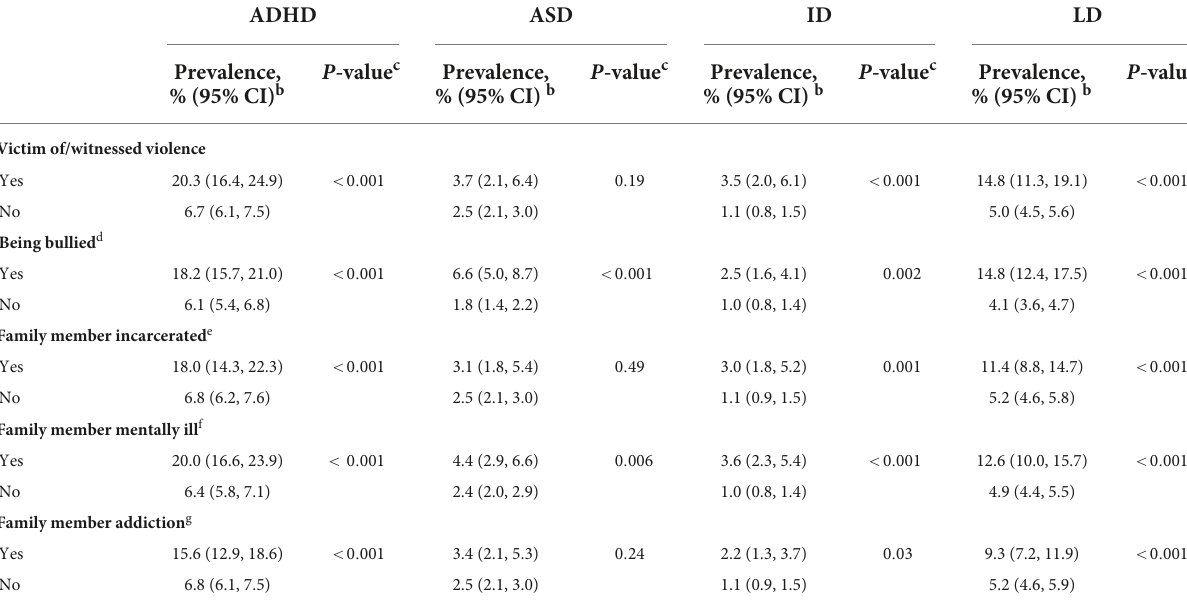
TABLE 2 Subgroup prevalence by stressful life events among US children and adolescents aged 3–17 years in 2019 a